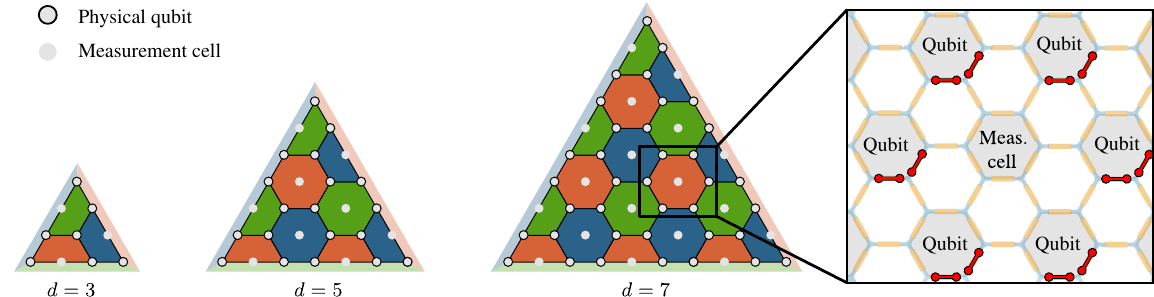
FIG. 8. First three topological triangular color codes with code distances 3, 5, and 7 (where the smallest one is equivalent to the Steane code [63]). These 6.6.6 color codes are defined on a hexagonal lattice, where each vertex is a physical qubit and each face is an X -type and a Z -type stabilizer involving the surrounding qubits. Physical errors on a qubit affect the three different-colored stabilizers and edges surrounding the qubit. In the triangular lattice of hexagonal-cell qubits, the empty cell in the center of each face can be used for stabilizer